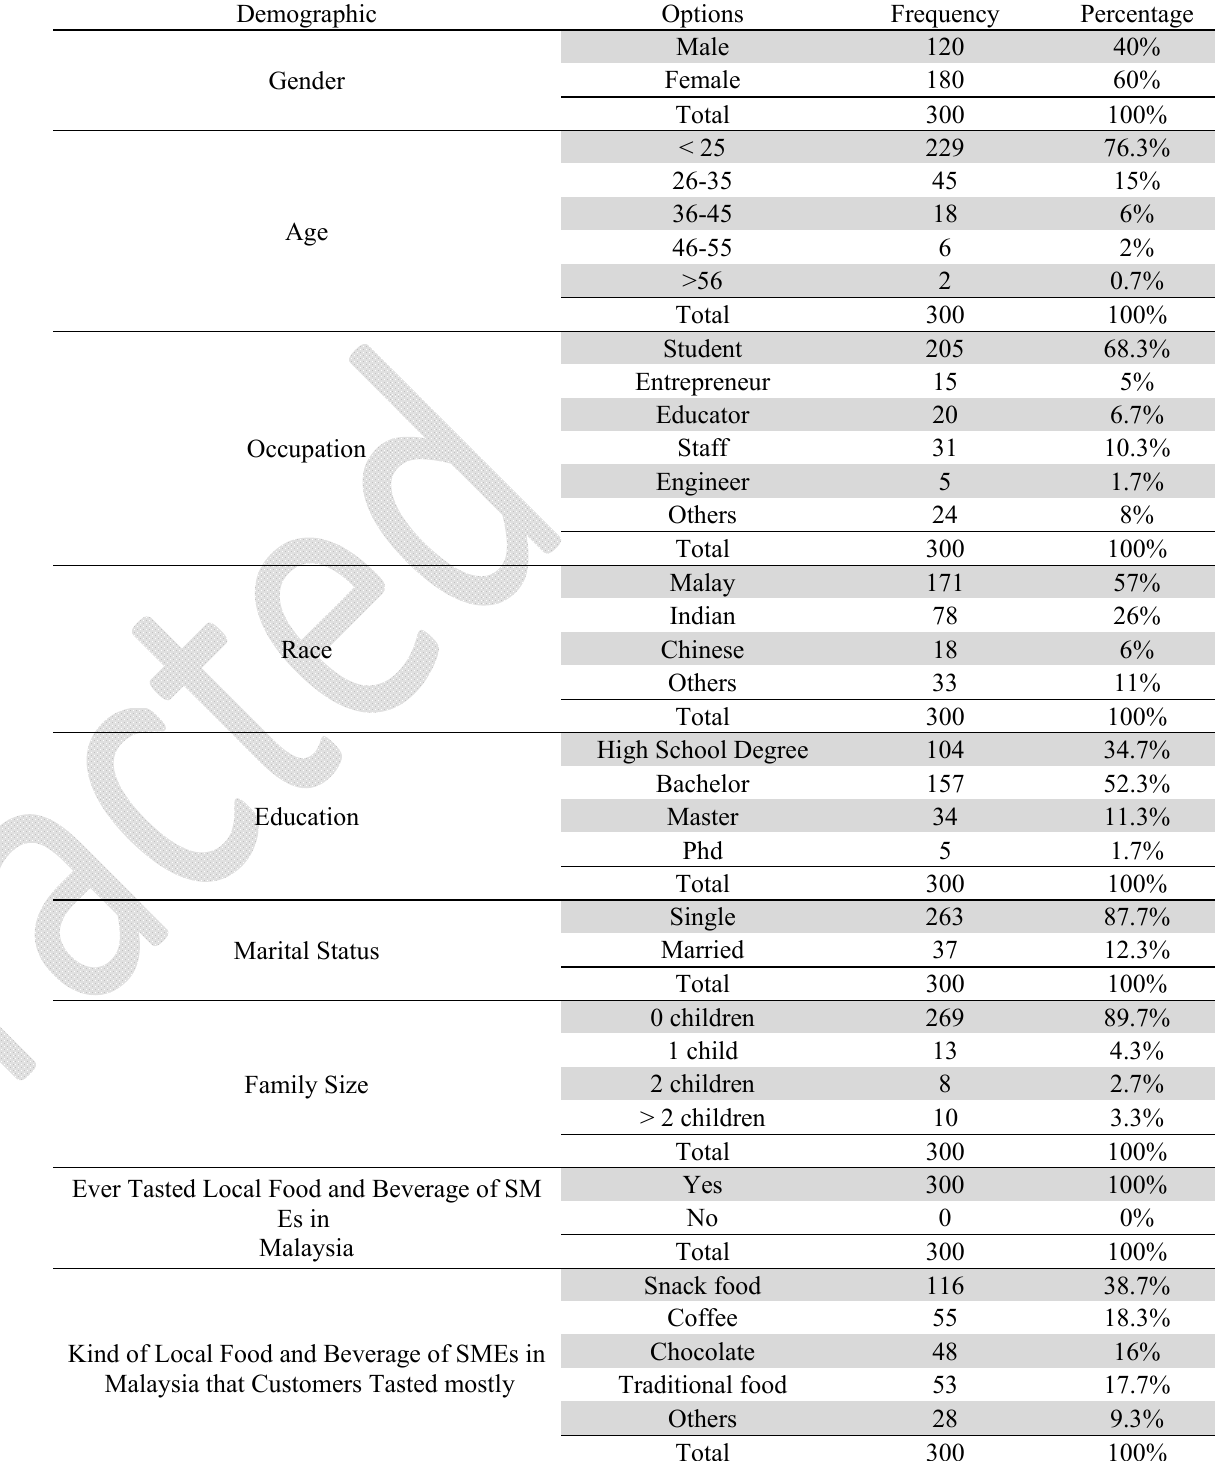
Demographic Profile of